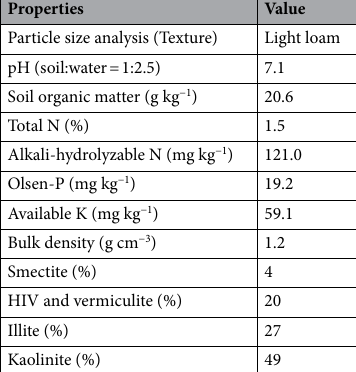
Table 1. Selected physicochemical properties of soils studied. HIV, hydroxyl-interlayered